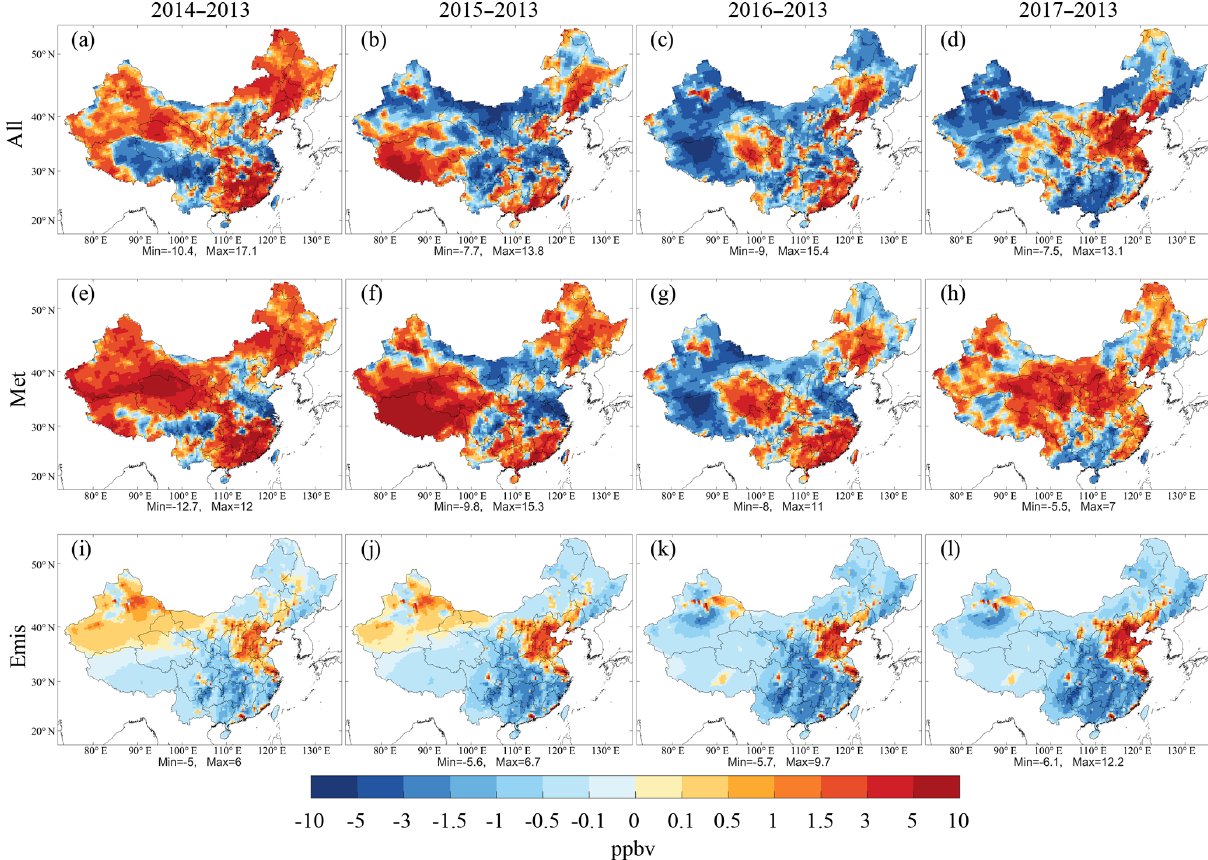
Figure 3. Changes in the simulated summer surface MDA8 O 3 mixing ratios from the base simulation (All, a–d ); those due to variations in meteorological conditions (Met, e–h ); and anthropogenic emissions (Emis, i–l ) in 2014, 2015, 2016, and 2017 relative to